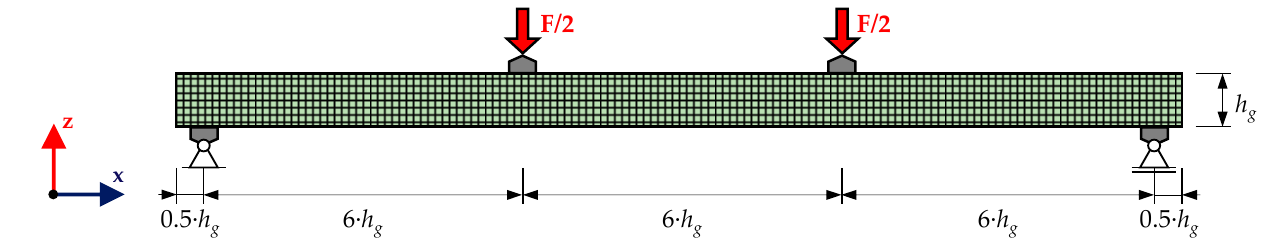
Figure 17. Test setup of four-point-bending tests in accordance with EN 408 [19] within the FE software package Ansys [38].